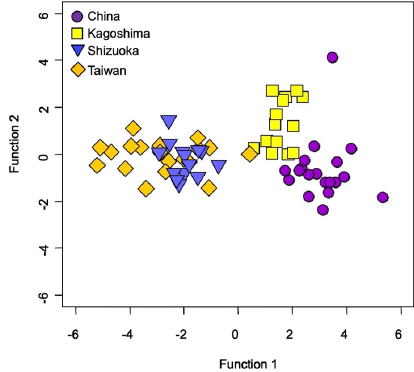
Figure 4. Quadratic discriminant function analysis among four aquaculture farms (China, Kagoshima Prefecture of Japan, Shizuoka Prefecture of Japan, and Taiwan) in East Asia based on all the otolith elemental ratios (Na:Ca, Mg:Ca, P:Ca, K:Ca, Sr:Ca, and Ba:Ca) in the Japanese eel ( Anguilla japonica ). Testing for the QDFA with jackknife cross-validation using all data (one hundred thirty-seven specimens and six elemental ratios), including a wild habitat and four aqua- culture farms, showed 82%, suggesting a high spatial variability of TEF in Japanese eel otoliths between wild and aquaculture environments (Figure 5).